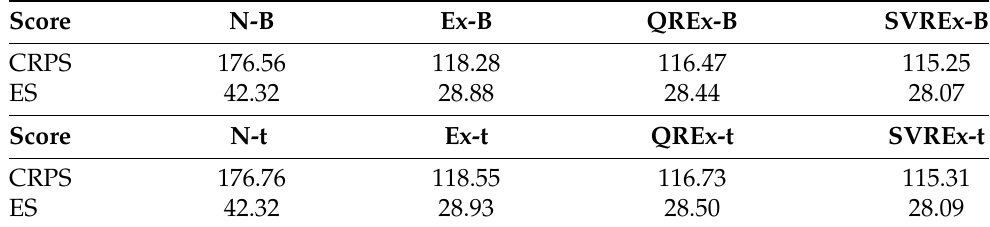
Table 4. Full Probabilistic Evaluation: Continuous Ranked Probability and Energy